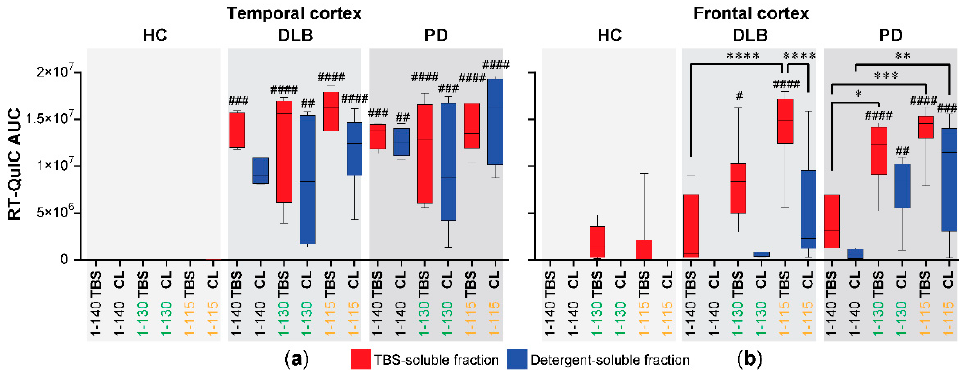
Figure 3. Comparisons of the aggregation of α Syn forms in RT-QuIC using brain homogenates from PD and DLB cases. TBS-aqueous and detergent-soluble (CelLytic, CL) fractions were prepared from ( a ) temporal and ( b ) frontal cortices of 8 cases of DLB, PD, or healthy controls (HC), then assayed by RT-QuIC using three different α Syn forms (full length 1-140 and truncated forms 1-130 or 1-115). The RT-QuIC reactions are shown in Figure 2. The box plots (median marked with a line and with maximum and minimum bars) summarize the area under the RT-QuIC curves (AUC). One-way ANOVA with Tukey’s multiple comparison testing (GraphPad Prism) was used for statistical comparisons. Hashtags denote significant differences in comparison to healthy controls (HC); # p < 0.05, ## p < 0.01, ### p < 0.001, #### p < 0.0001. Asterisks denote significant differences within DLB or PD; * p < 0.05, ** p < 0.01, *** p < 0.001, **** p < 0.0001. Table 1. ROC curve analysis of RT-QuIC data with PD and DLB cases with different α Syn forms.